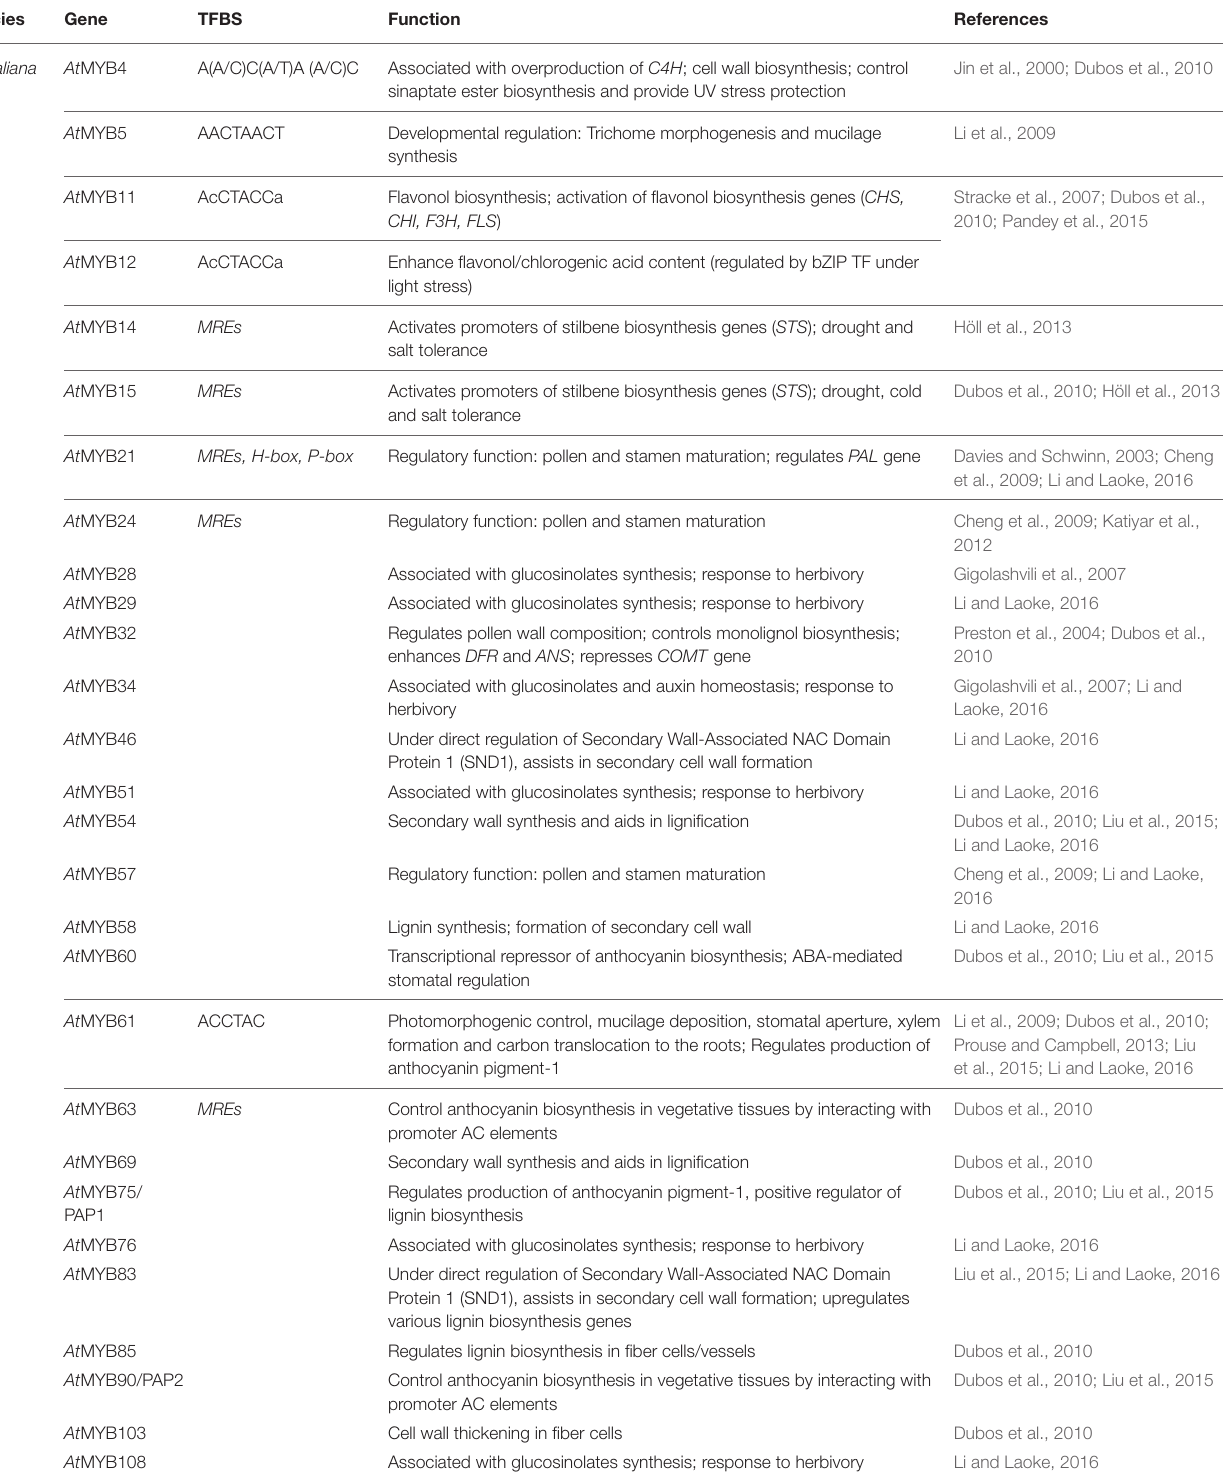
TABLE 3 | R2R3-MYB TFs in regulating primary and specialized metabolism in plants.